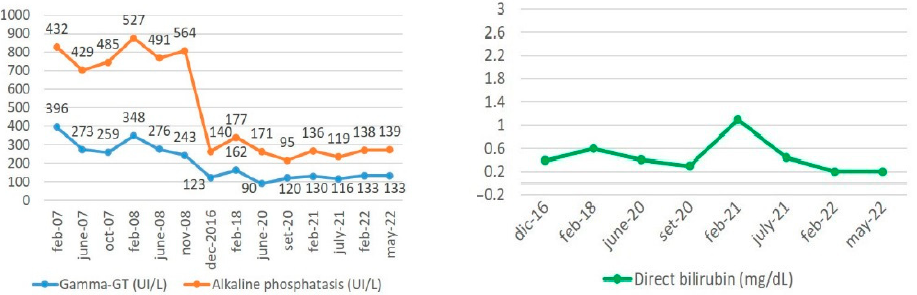
Figure 1. Trend over time of gamma–GT, alkaline phosphatase, and direct bilirubin blood values.